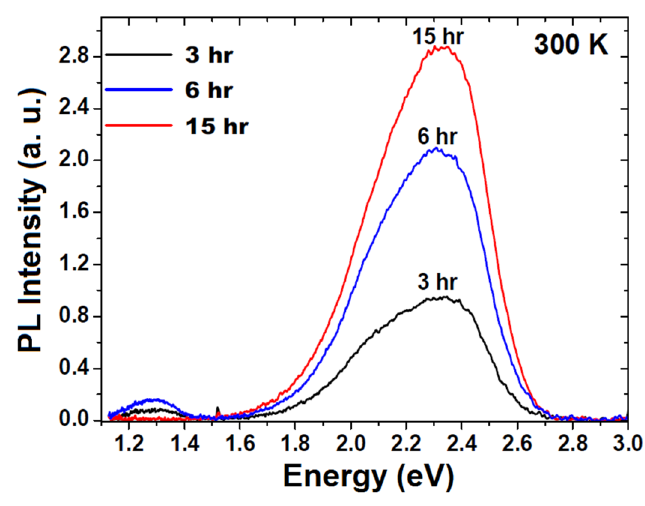
Figure 4. PL spectra at 300 K of ZnO with copper diffusion at different diffusion times.